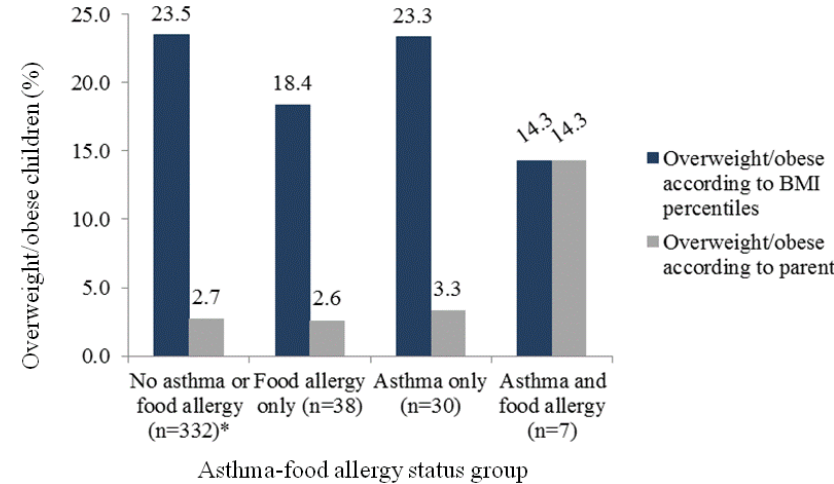
Figure 1. Overweight/obese children (%) in the asthma-food allergy status groups according to BMI percentiles (dark blue) and parental perception of the child’s current weight (gray).